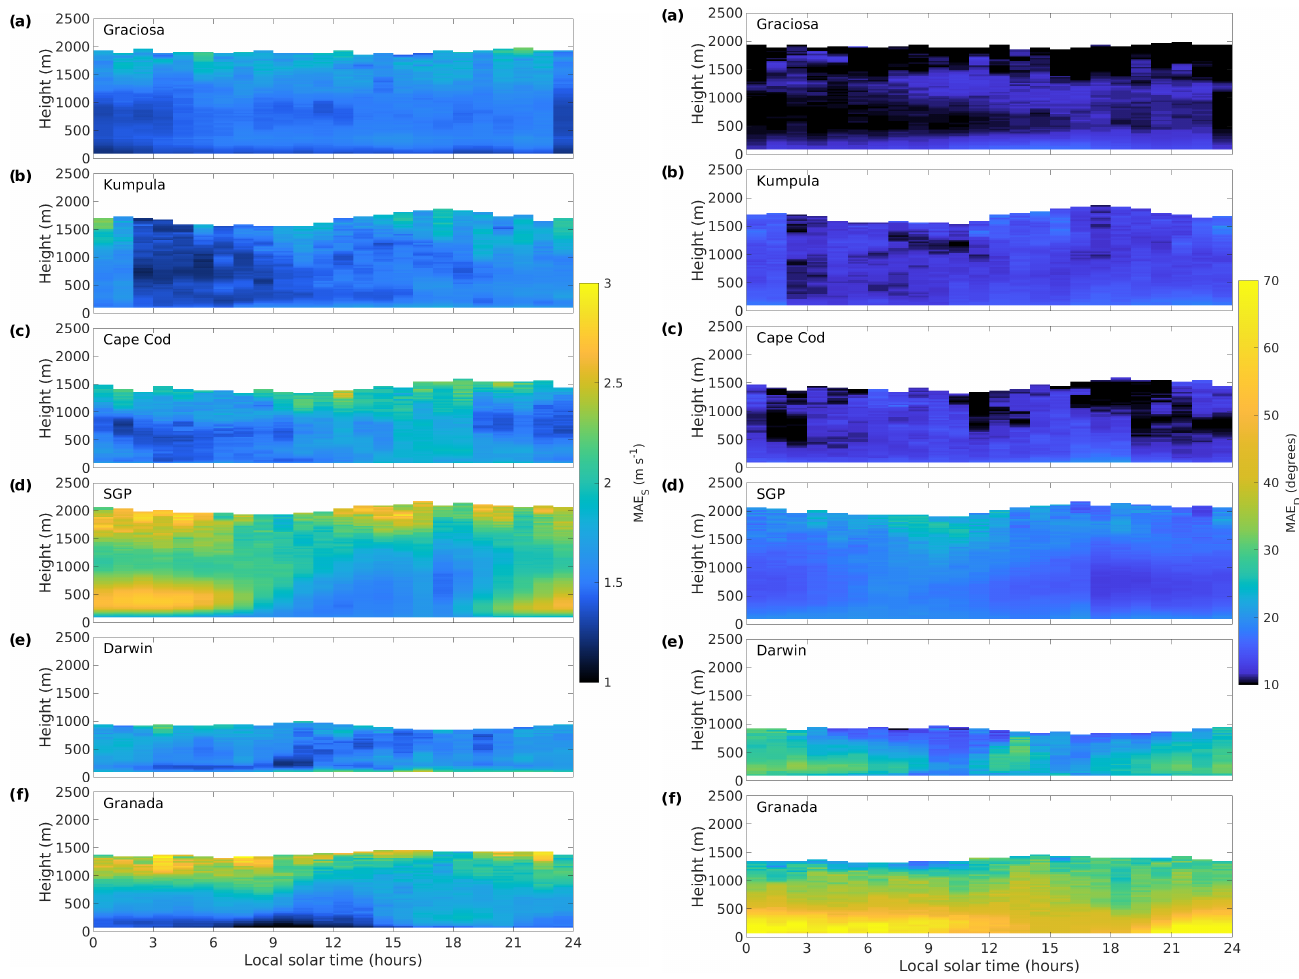
Figure A1. Diurnal composites of mean absolute wind speed error at (a) Graciosa, (b) Kumpula, (c) Cape Cod, (d) SGP, (e) Darwin, and (f) Granada. Time refers to approximate local solar time.